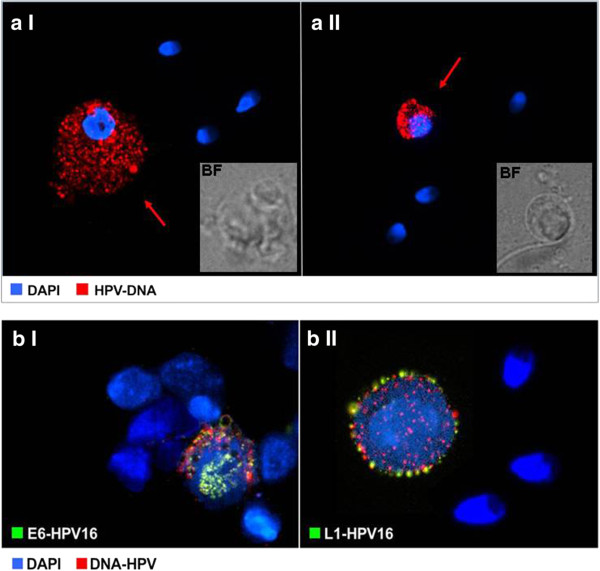
Analysis of HPV-16 markers in non-spermatozoal cells from semen samples. a: FISH analysis of HPV-16 DNA in non-spermatozoal cells from semen samples. a I epithelial and a II non epithelial positive cells. Reference brigh-fiels pictures (BF) are added as inserts. b: FISH and immunofluorescence analysis of HPV16-E6 or HPV16-L1 expression on HPV-DNA bearing non-spermatozoal cells. b I HPV16-E6 protein and b II HPV16-L1 protein positive round cells.